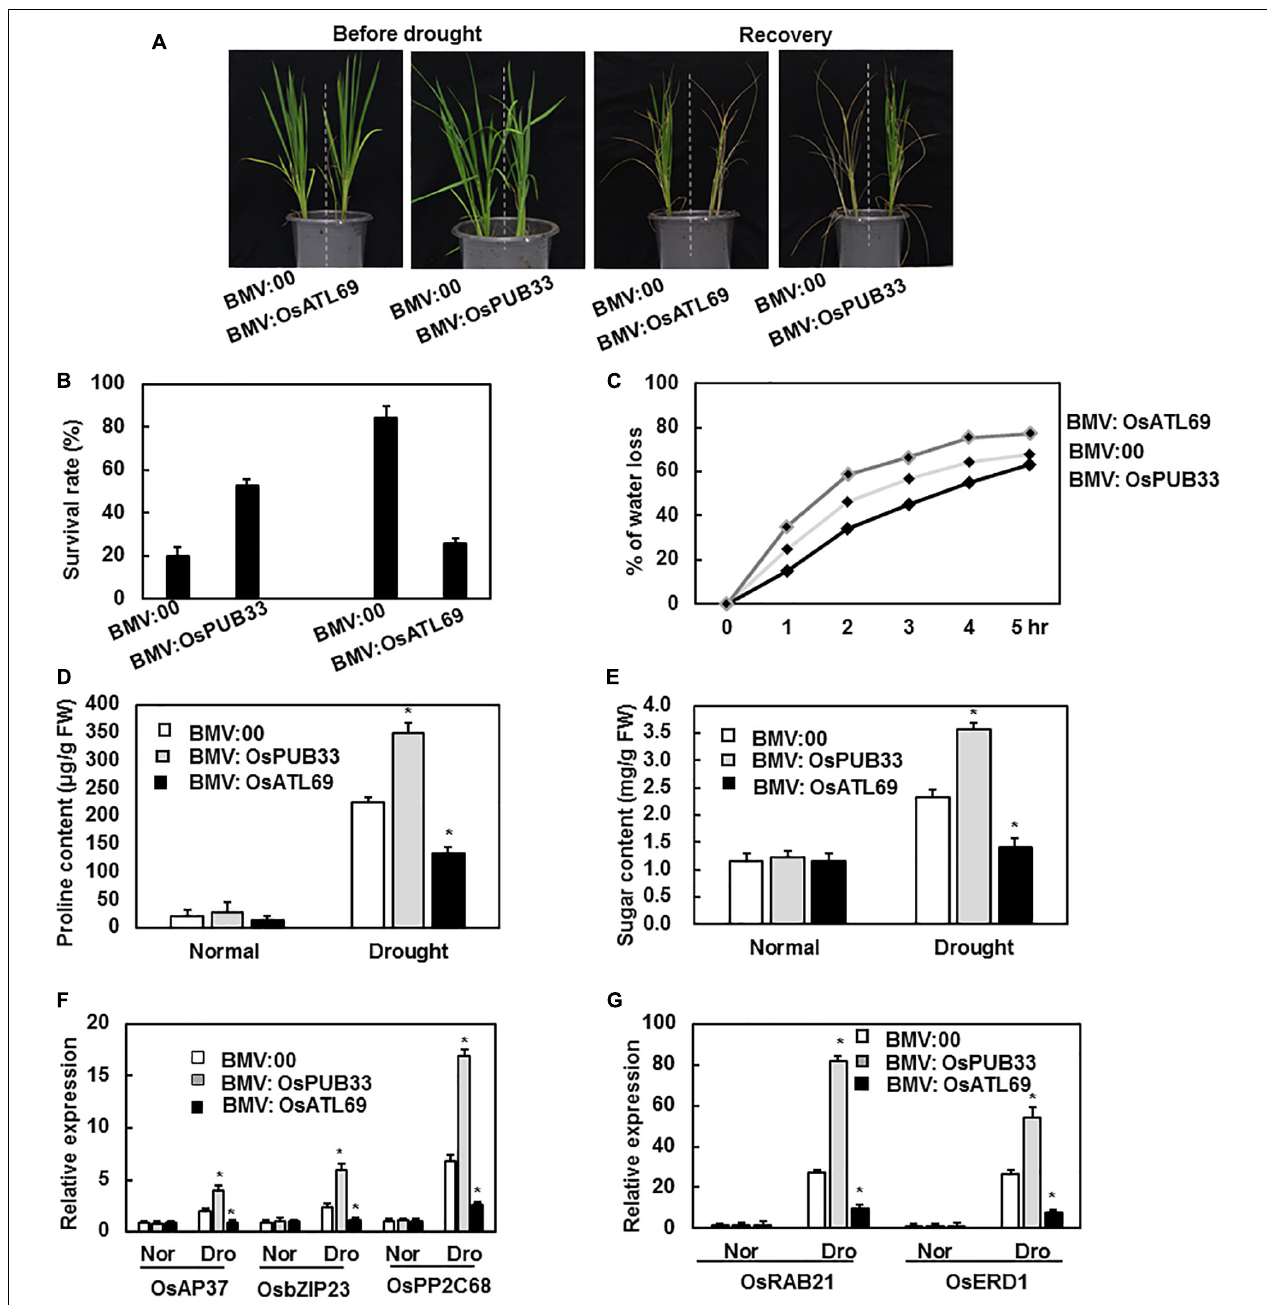
FIGURE 5 | BMV:OsATL69-infiltrated seedlings showed decreased tolerance to drought stress while BMV:OsPUB33-infiltrated seedlings showed increased tolerance to drought stress. The BMV:OsATL69- and BMV:00-infiltrated seedlings in the same pot were withheld watering for 10 days and recovered with normal watering for another 12 days. The phenotype (A) and the survival rate (B) of BMV:target gene- and BMV:00-infiltrated seedlings after suffered drought stress. BMV:OsATL69- and BMV:00-infiltrated seedlings in the same pot were withheld watering for 10 days and recovered with normal watering for another 12 days. And BMV:OsPUB33- and BMV:00-infiltrated seedlings in the same pot which were withheld watering for 15 days and recovered with normal watering for another 12 days. (C) Water loss of BMV:OsATL69- and BMV:00-infiltrated seedlings after exposure to drought stress for different times. Proline content (D) and sugar content (E) of BMV: OsATL69-, BMV: OsPUB33-, and BMV:00-infiltrated seedlings after exposure to drought stress for 10 days. (F,G) The expression levels of drought-responsive genes were upregulated in BMV:OsPUB33-infiltrated plants and downregulated in BMV:OsATL69- infiltrated plants, when compared to the control after drought stress. Expression levels were shown as multiples of the OsActin expression level, which was used as a standard. Data presented are the means ± SD from three independent experiments, and * above the columns indicate significant differences between BMV:target genes- and BMV:00-infiltrated plants at p < 0.05 level.